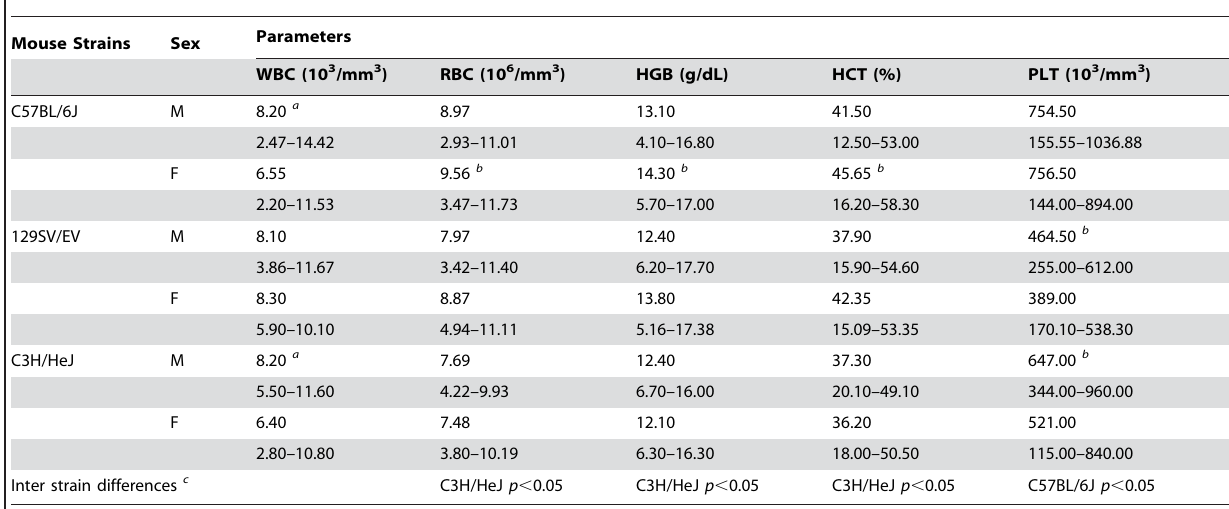
Table 2. Hematological parameters (median and 2.5 th –97.5 th percentiles interval) measured in aged 3–7 months C57BL/6J, 129SV/ EV and C3H/HeJ mouse strains (n=